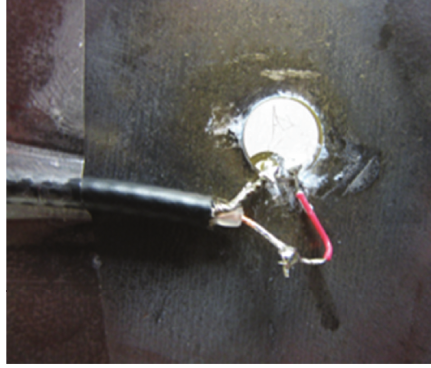
Figure 9: PWAS installation using a coaxial cable.